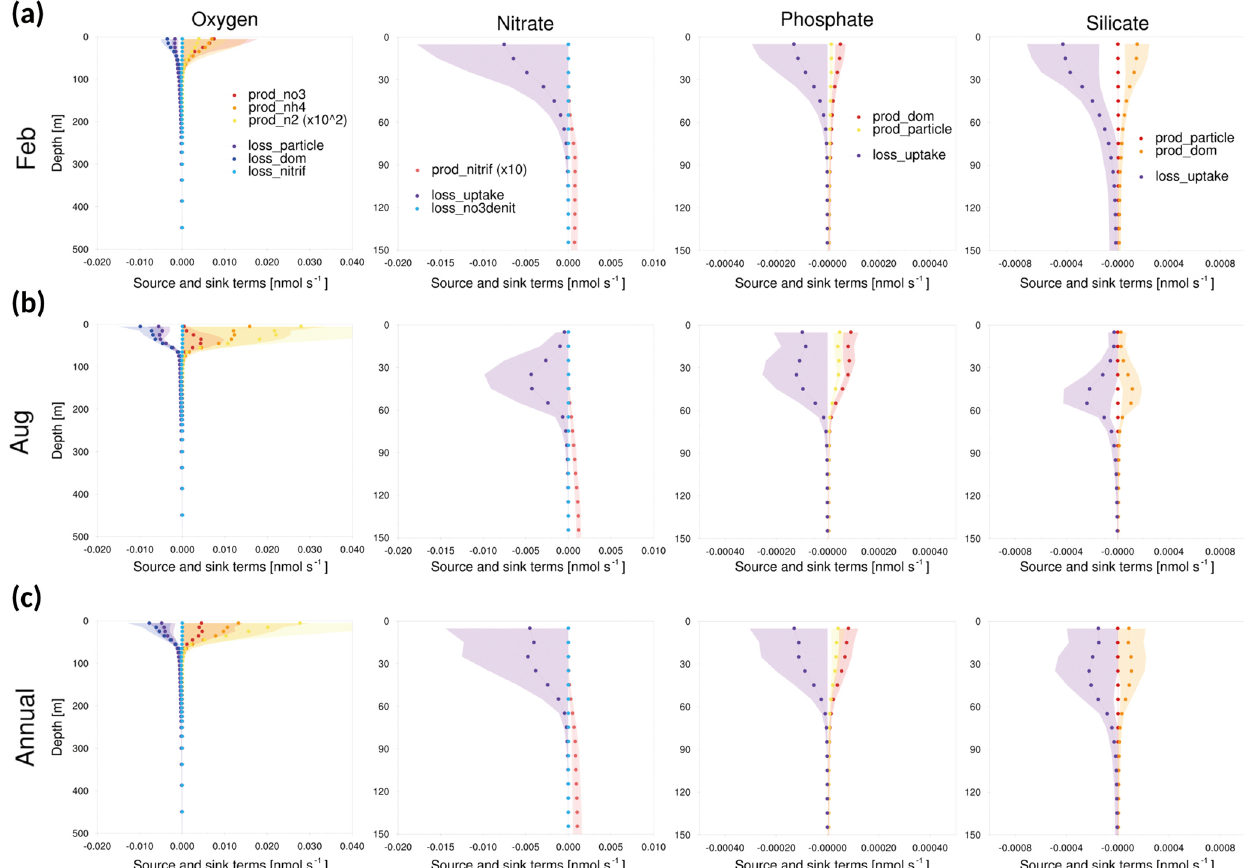
Figure 13. Vertical profiles of the tendencies of source and sink terms in GOTM–TOPAZ at point 102 for the 10-year period of 1999–2008, (a) for February, (b) for August, and (c) annually. The shaded areas represent 1 σ